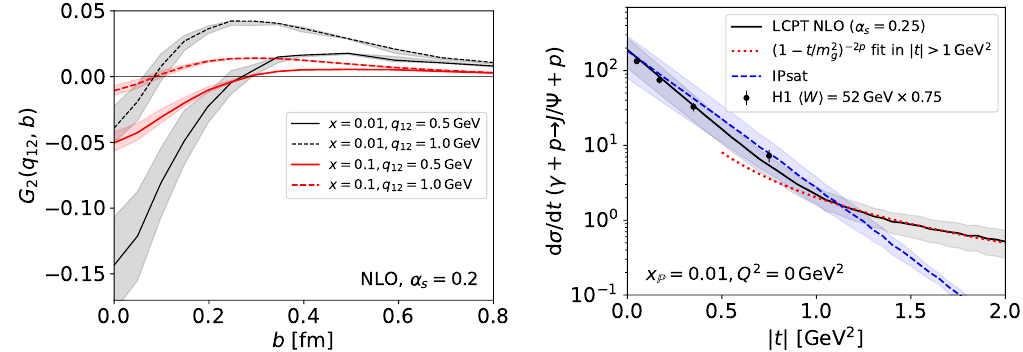
(cid:126) ( (cid:126) q b ) as a function of impact parameter , 2 12 [ 22 ] . The bands indicate the vari- 12